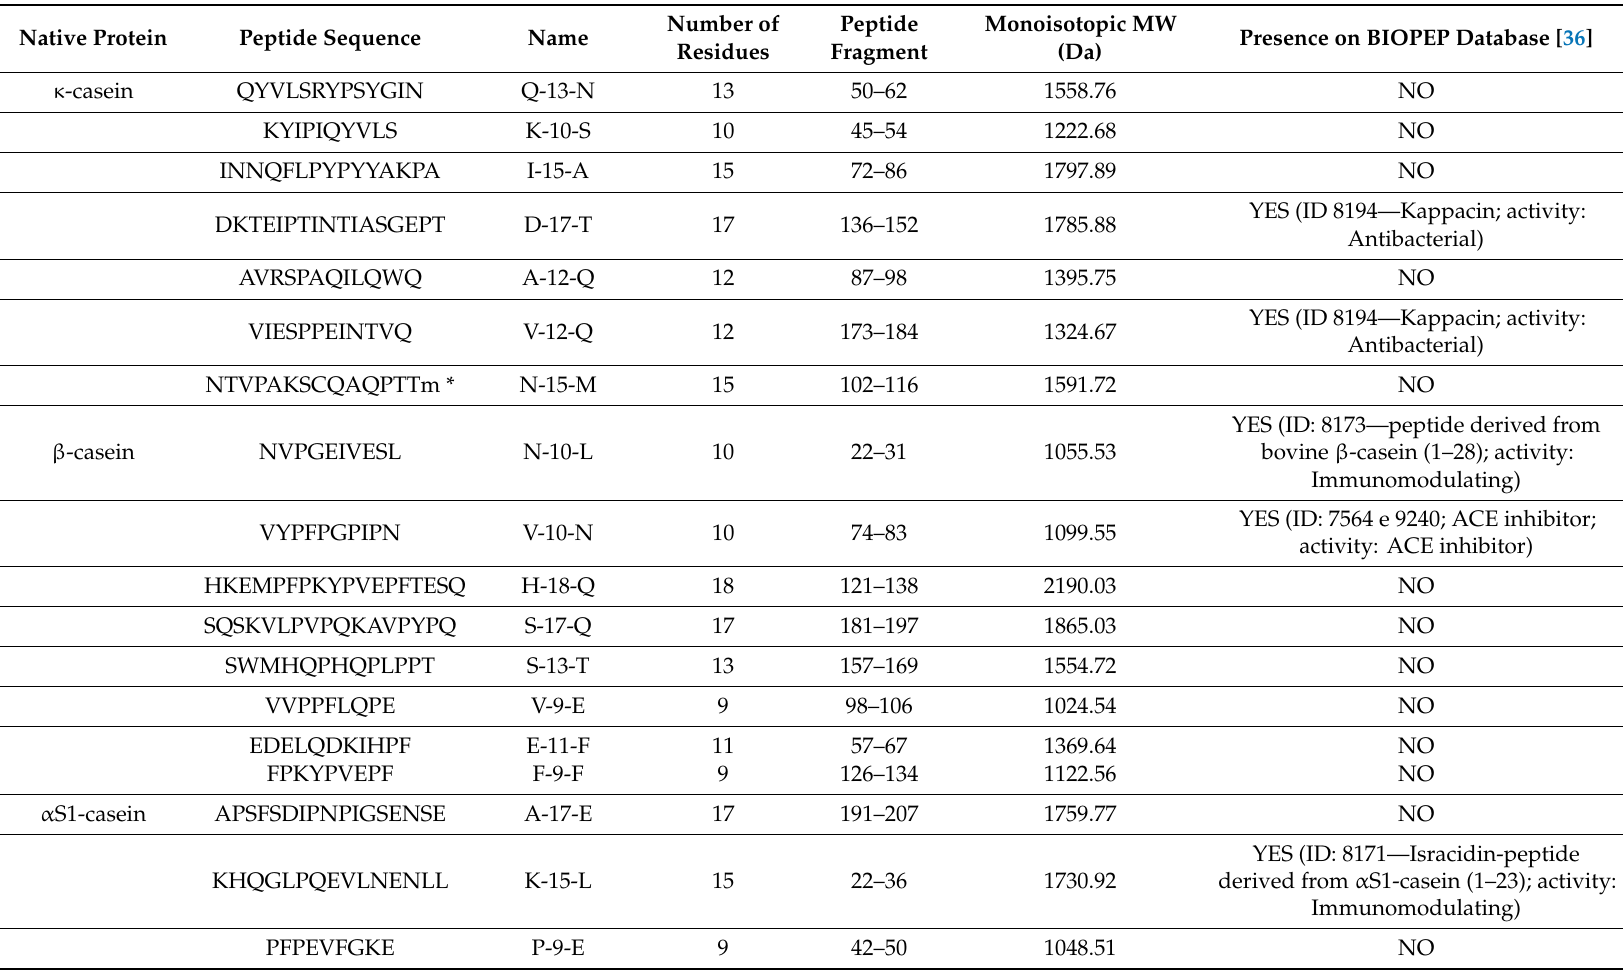
Table 2. Sequences and characteristics of the synthesized